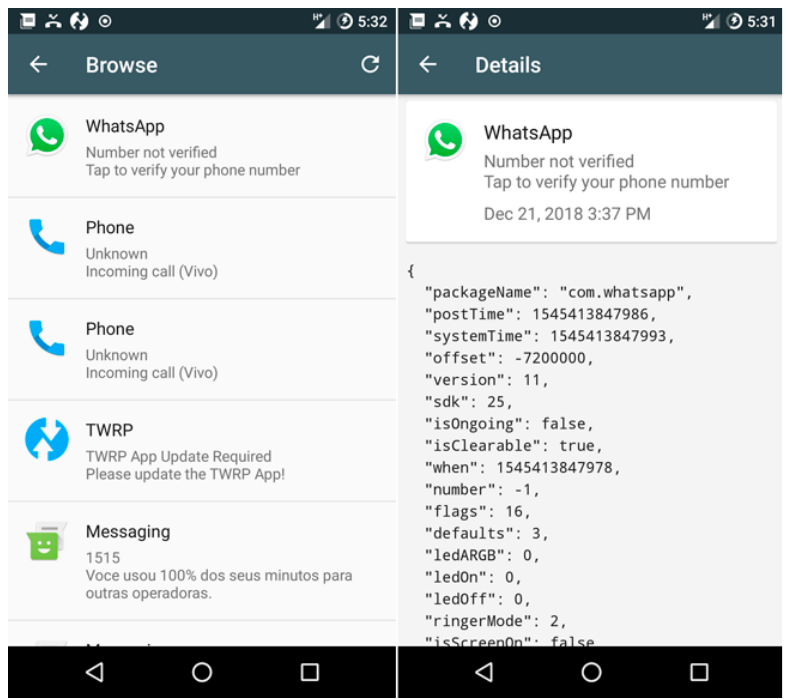
Figure 7. List notifications and details for only